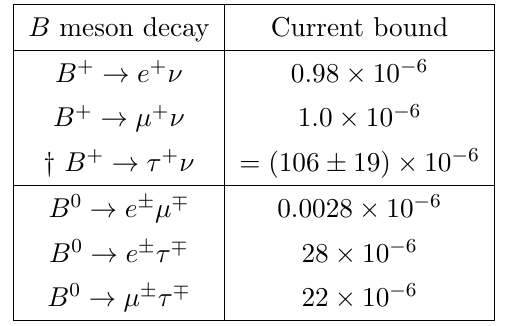
Table 4 . Leptonic ((cid:13)avour violating and (cid:13)avour conserving) B -meson decay modes. The symbol y denotes a measurement rather than an upper